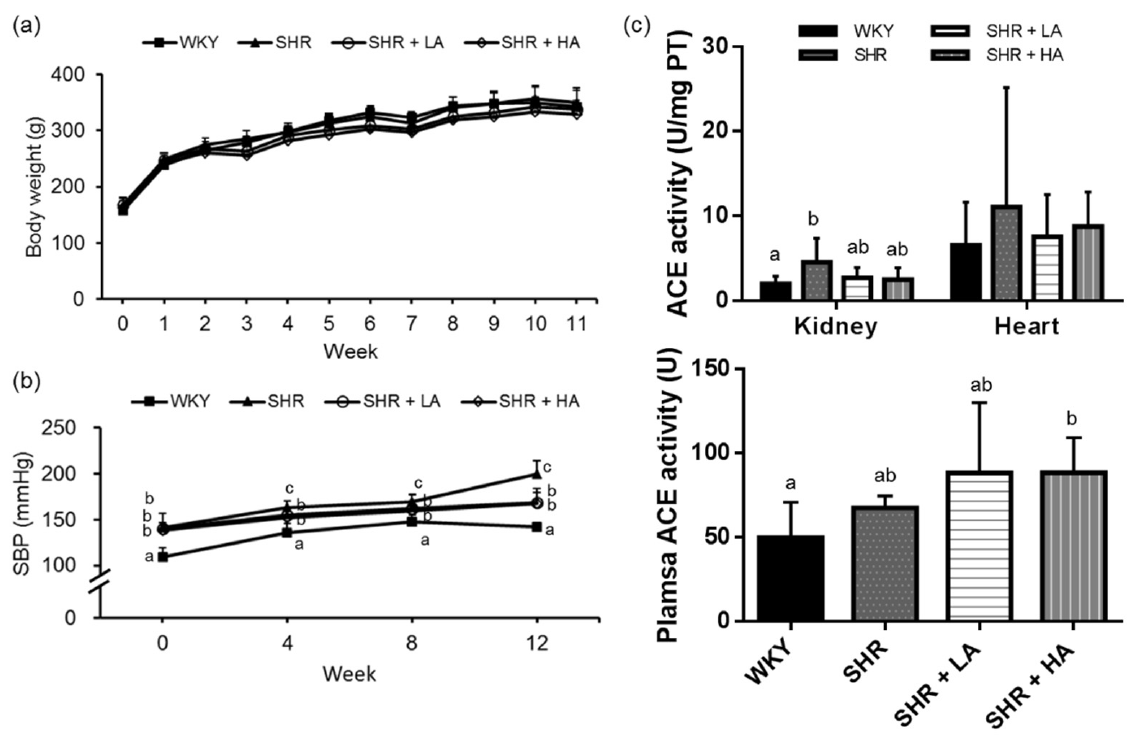
Figure 2. Food intake ( a ), SBP ( b ), and plasma and tissue ACE activities ( c ) of rats in different groups. Values are presented as mean ± SD ( n = 10). abc Different superscript letters indicate a significant difference ( p < 0.05). SBP, systolic blood pressure; ACE, angiotensin-converting enzyme. WKY, Wistar Kyoto) rats fed an AIN-93M diet; SHR, spontaneously hypertensive rats fed an AIN-93M diet; SHR + LA, SHRs fed an AIN-93M diet containing 12% dehulled adlay powder; SHR + HA, SHRs fed an AIN-93M diet containing 24% dehulled adlay powder.